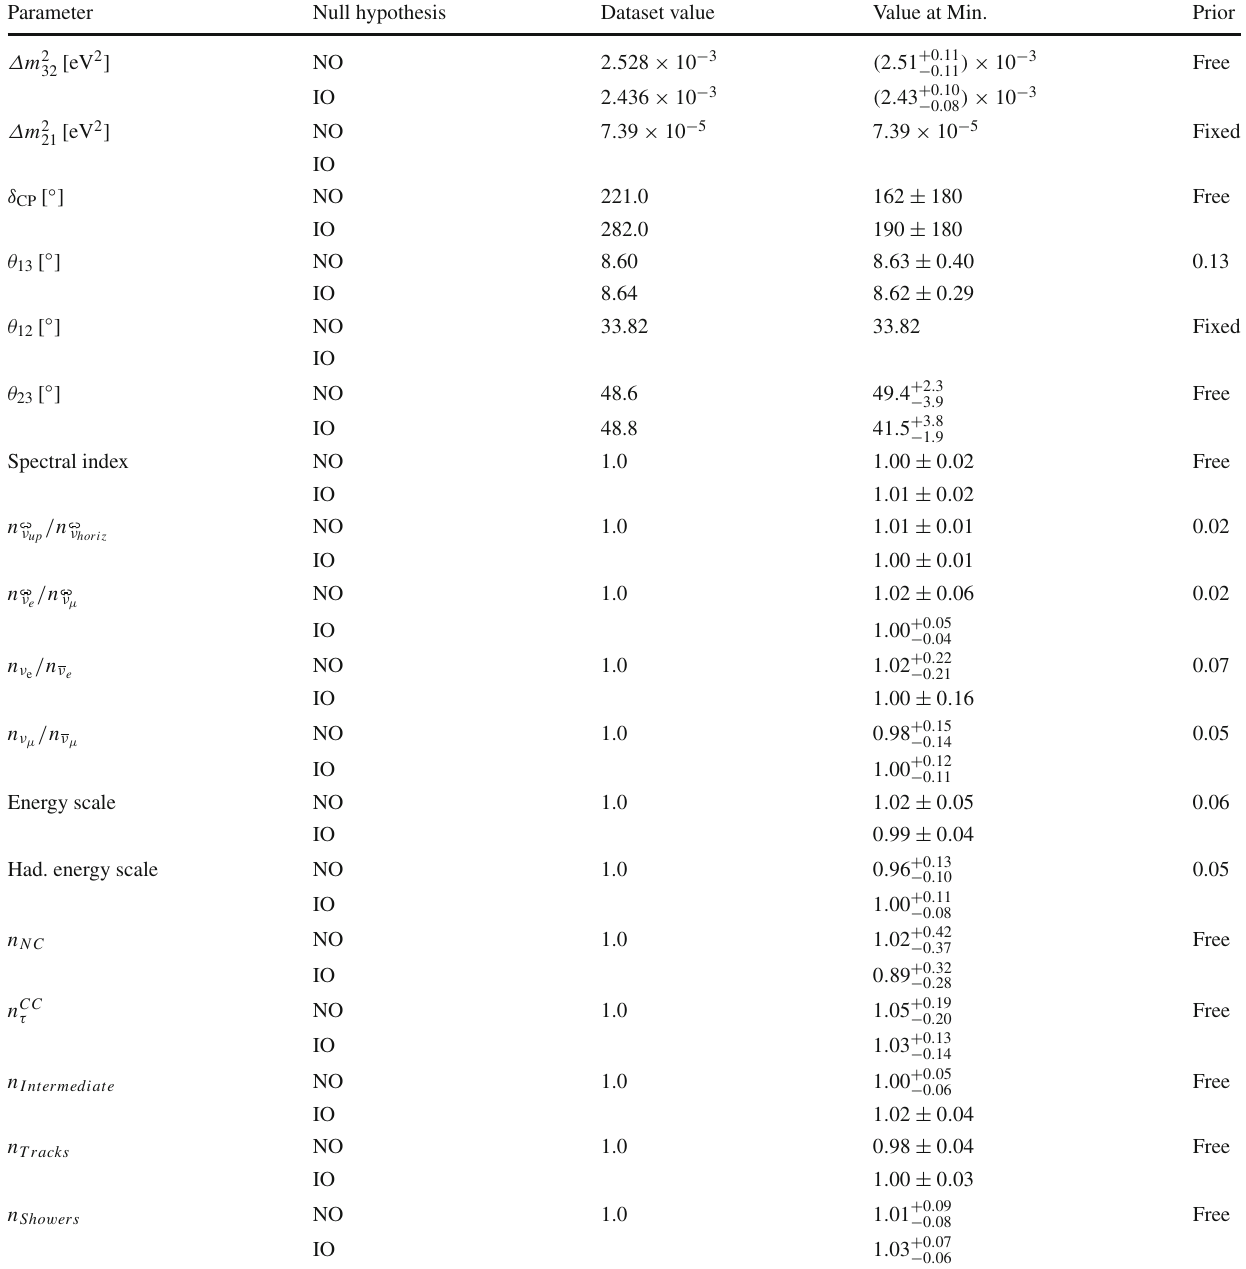
parameter uncertainties are defined as the values by which the parame- ter has to vary to increase LL by 1.0. For each parameter value scanned, LL is minimised over the other free parameters